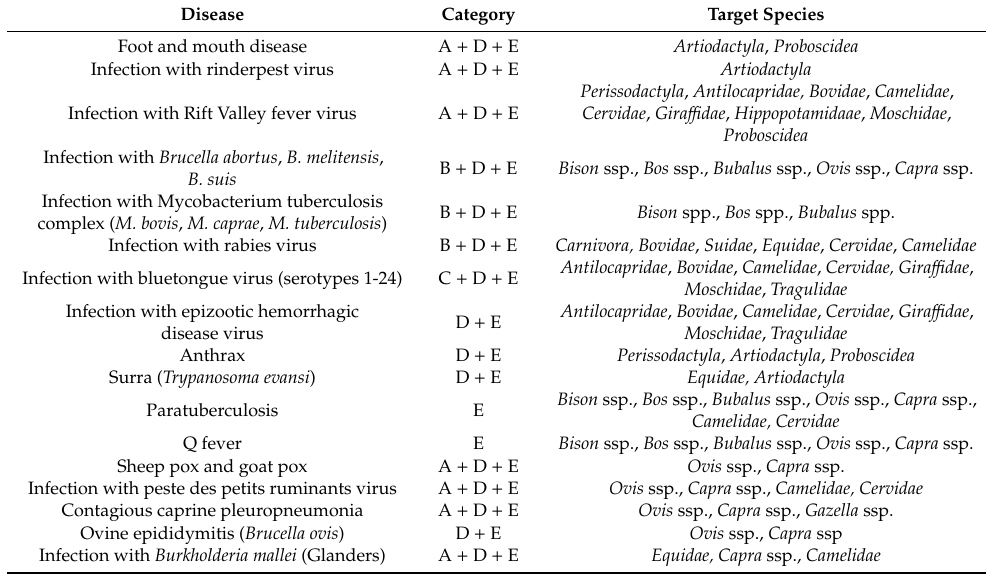
Table 1. Listed diseases related to small ruminants, their category, and range of target species. Disease Category Target Species Foot and mouth disease A + D + E Artiodactyla , Proboscidea Infection with rinderpest virus A + D + E Artiodactyla Perissodactyla , Antilocapridae, Bovidae , Camelidae , Cervidae , Gira ffi dae , Hippopotamidaae , Moschidae , Infection with Rift Valley fever virus A + D + E Proboscidea Infection with Brucella abortus , B. melitensis , B + D + E Bison ssp., Bos ssp., Bubalus ssp., Ovis ssp., Capra ssp. B. suis Infection with Mycobacterium tuberculosis B + D + E Bison spp., Bos spp., Bubalus spp. complex ( M. bovis , M. caprae , M. tuberculosis ) Infection with rabies virus B + D + E Carnivora, Bovidae , Suidae , Equidae , Cervidae , Camelidae Antilocapridae , Bovidae , Camelidae , Cervidae, Gira ffi dae , Infection with bluetongue virus (serotypes 1-24) C + D + E Moschidae , Tragulidae Antilocapridae , Bovidae , Camelidae , Cervidae , Gira ffi dae , Infection with epizootic hemorrhagic D + E Moschidae , Tragulidae disease virus Anthrax D + E Perissodactyla , Artiodactyla , Proboscidea Surra ( Trypanosoma evansi ) D + E Equidae, Artiodactyla Bison ssp., Bos ssp., Bubalus ssp., Ovis ssp., Capra ssp., Paratuberculosis E Camelidae, Cervidae Q fever E Bison ssp., Bos ssp., Bubalus ssp., Ovis ssp., Capra ssp. Sheep pox and goat pox A + D + E Ovis ssp., Capra ssp. Infection with peste des petits ruminants virus A + D + E Ovis ssp., Capra ssp., Camelidae, Cervidae Contagious caprine pleuropneumonia A + D + E Ovis ssp., Capra ssp., Gazella ssp. Ovine epididymitis ( Brucella ovis ) D + E Ovis ssp., Capra ssp Infection with Burkholderia mallei (Glanders) A + D + E Equidae, Capra ssp.,